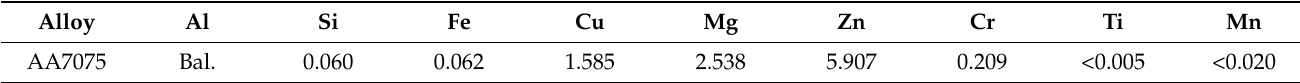
Table 7. Chemical composition of as-received Al 7075 powder in wt. %.